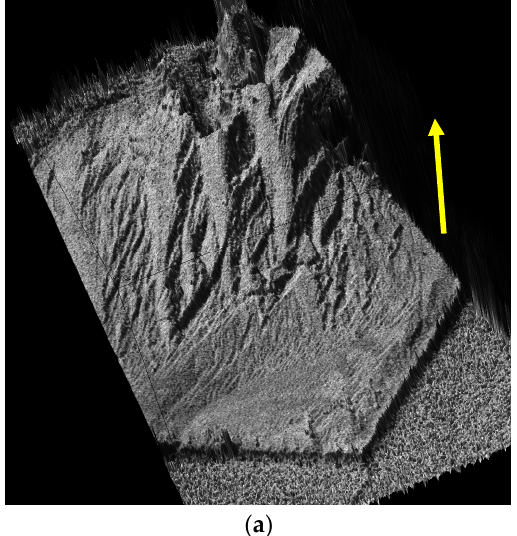
Figure 9. AFM images of the free surfaces of specimens 1 and 3. ( a ) intensive slip traces near the crack tip in specimen 1, ( b , d ) 3D and 2D views of the activity of three slip systems in specimen 3 area I, and ( c ) fading of the third slip system in area F (Figure 7).